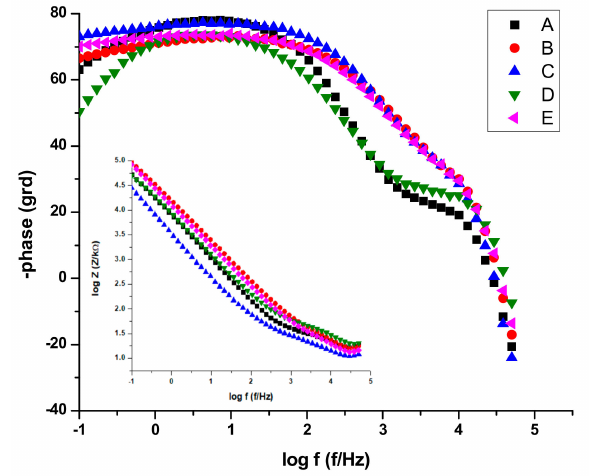
Figure 14. Bode plots for all stainless-steel samples in NaCl